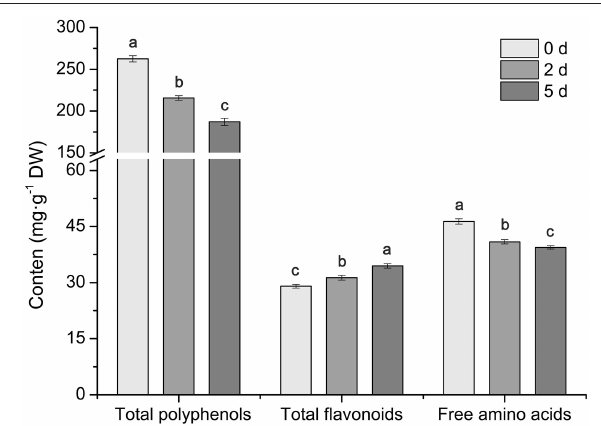
TABLE 2 | Drought stress-induced changes in content of theanine and other free amino acids (mg · g − 1 DW). Amino acid